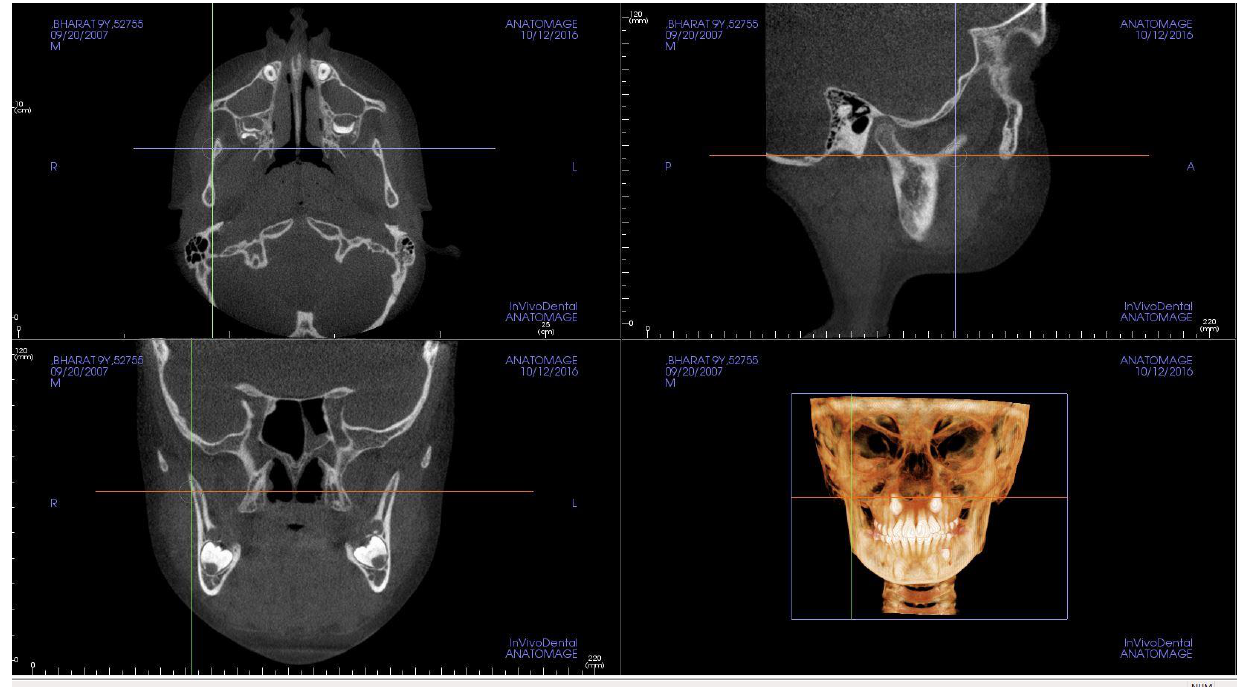
Figure 3. Standardization on MPR view for condyle-glenoid fossa measurements.